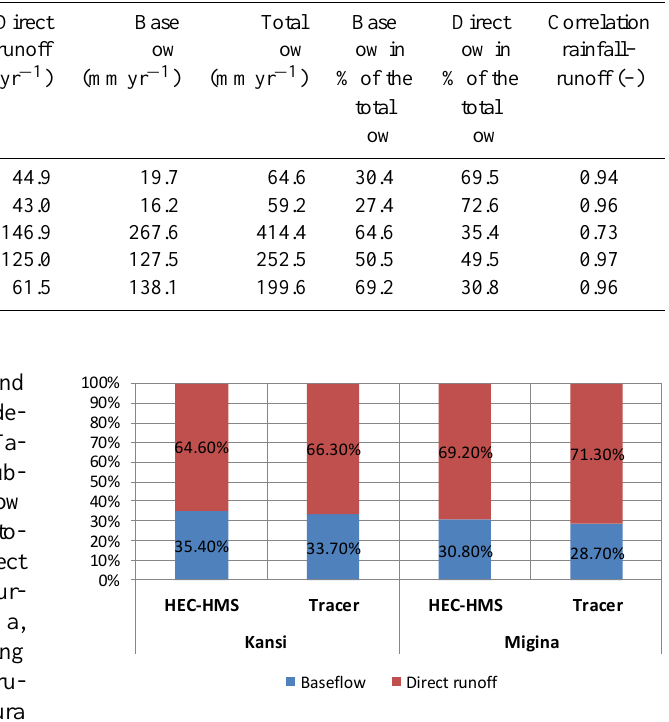
Figure 4. Comparison of flow component results using HEC-HMS Figure 4 Comparison of flow components results using HEC-HMS model (current study) and hydrochemical tracer model (current study) and hydrochemical tracer method (obtained method (obtained from Munyaneza et al., 2012a) for two investigated events in the rainy season in 2010 and 2011, from Munyaneza et al., 2012a) for two investigated events in the using flow data collected at Kansi and Migina river gauging stations. rainy season in 2010 and 2011, using flow data collected at Kansi and Migina river gauging